Question: Reading the figure, is the described quantity rising or falling?
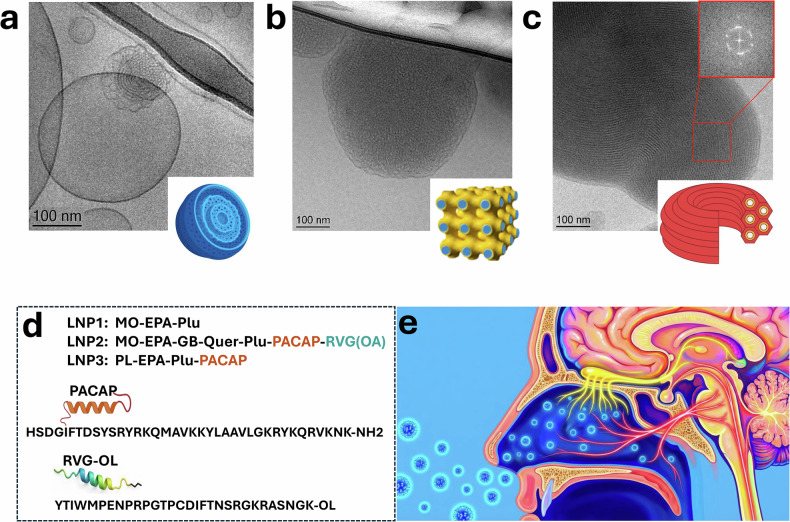
Answer: increasing